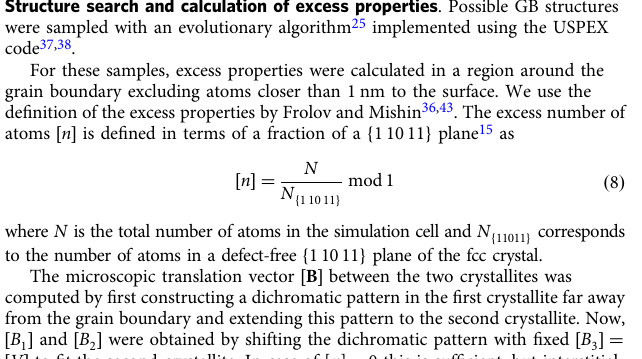
Fig. 1. Site-speci fi c plane-view FIB lamellas have been lifted out and thinned using the Scios 2 DualBeam SEM/FIB microscope, starting with a gallium ion beam voltage and current of 30kV and 0.1nA and ending at 5kV,